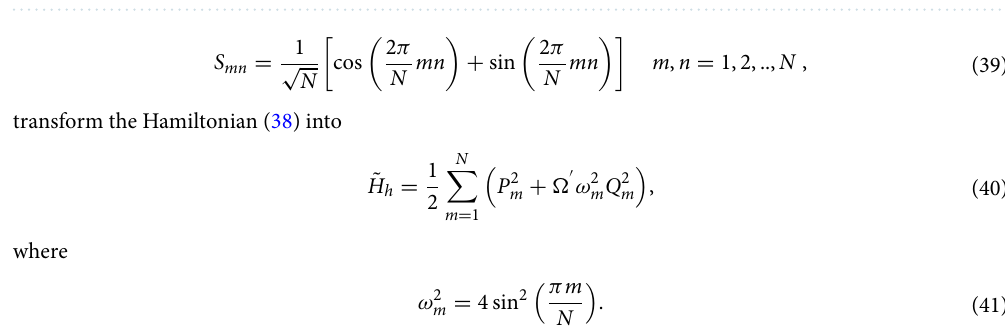
2 ψ( t ) along the chain of N | | 310 30 , J 5 , χ 1.2 , µ 0.8 , (cid:31) 0.1 , corresponding to E 0 10 , ǫ E ◦ , K ′ = ′ = ′ = ′ = ′ = ′ = = 0.0329 eV, χ 18.3 N/m, respectively. The right figure is the above view of 100 pN, (cid:31) = = = 13